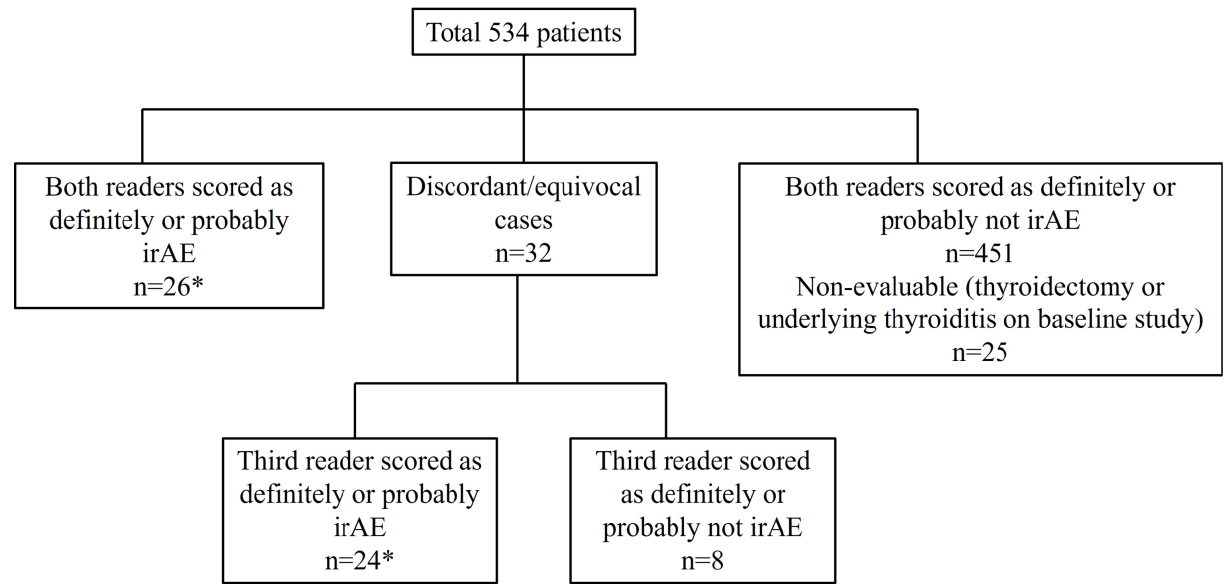
Figure 1. Flow chart for the radiologic review of readers. A total of 50 patients (marked as asterisks) showed CT findings indicative of immune-related thyroiditis.